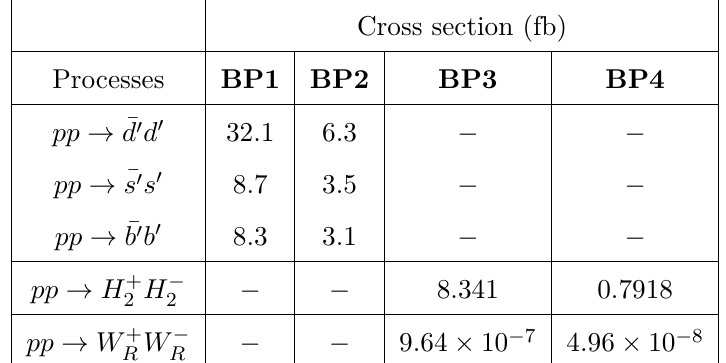
Table 8 . Cross sections of the pair production of exotic quarks, lightest charged Higgs and the right-handed charged gauge bosons at the 14 TeV LHC for the four different BP ’s considered.